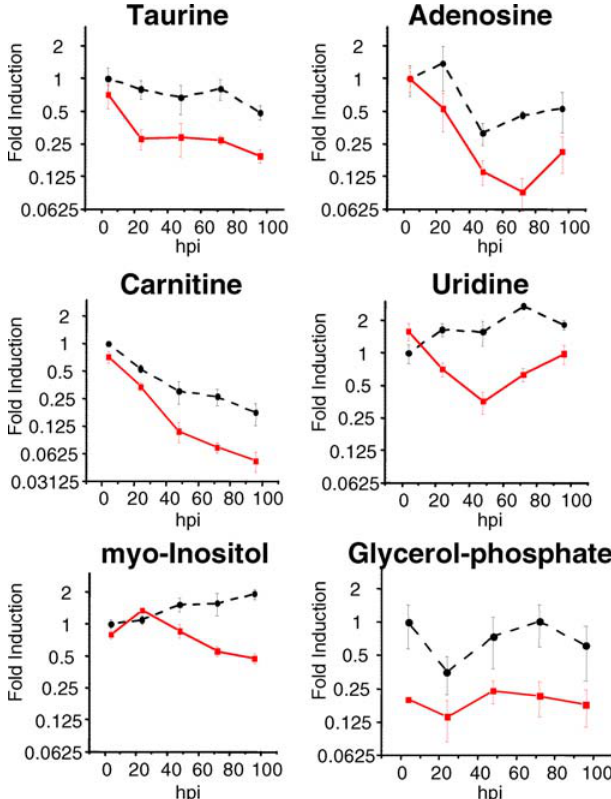
Figure 6. HCMV-Induced Decreases in Selected Metabolite Pools Metabolite data from mock-infected (dotted line) or virally infected (red line) fibroblasts are plotted as described in the Figure 1 legend.